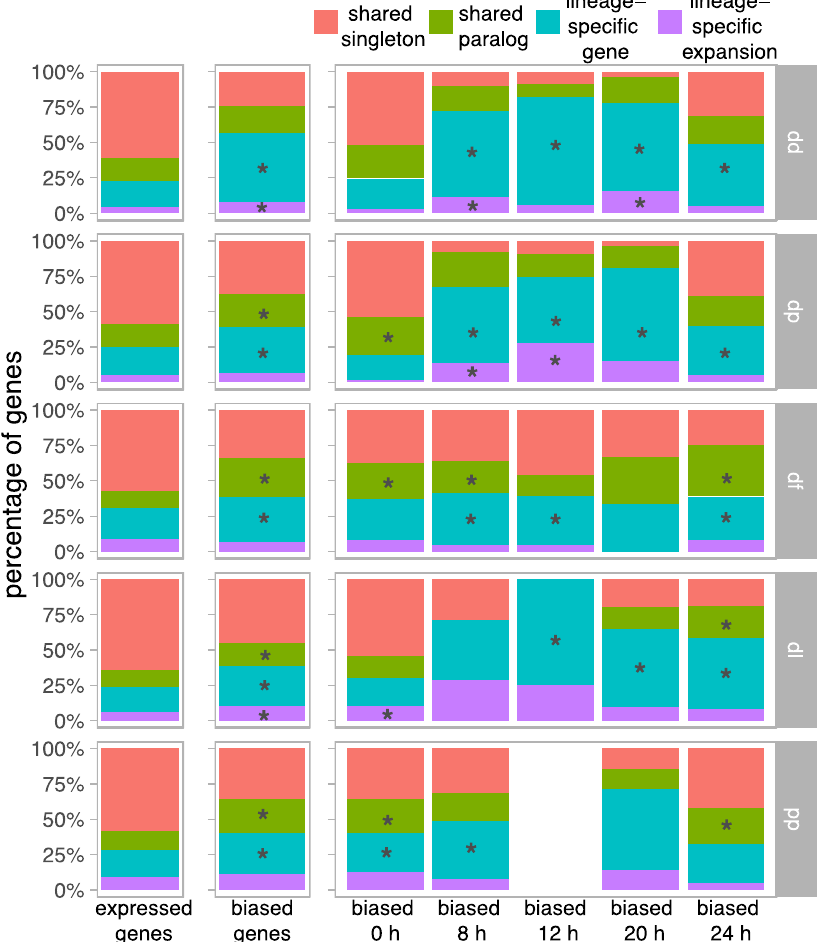
Figure 2. Contributions of gene categories among biased genes. Stacked bar charts showing the percentage of all expressed genes and all biased genes that belong to each of the four gene categories. Biased genes are also divided into the developmental stage in which expression bias is observed (i.e., where expression is highest): vegetative growth (0 h), aggregation (8 h), mound (12 h), early fruiting body (20 h), and late fruiting body (24 h). Asterisks (*) denote gene categories that are significantly enriched based on a chi-square test (FDR-corrected p < 0.05). There were no biased genes in pp at 12 h.